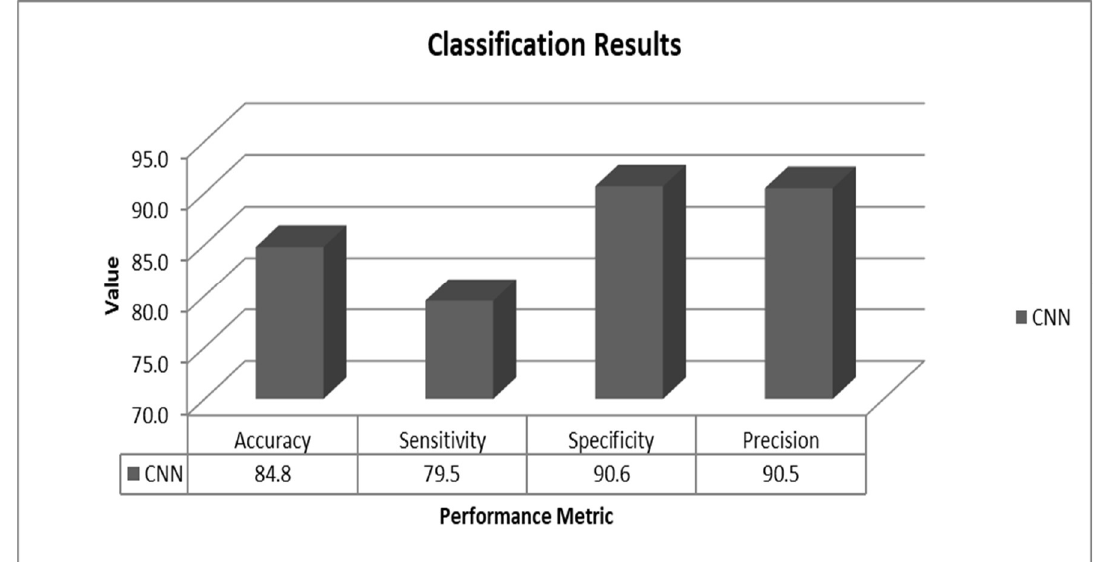
Figure 10. Results for the proposed method.